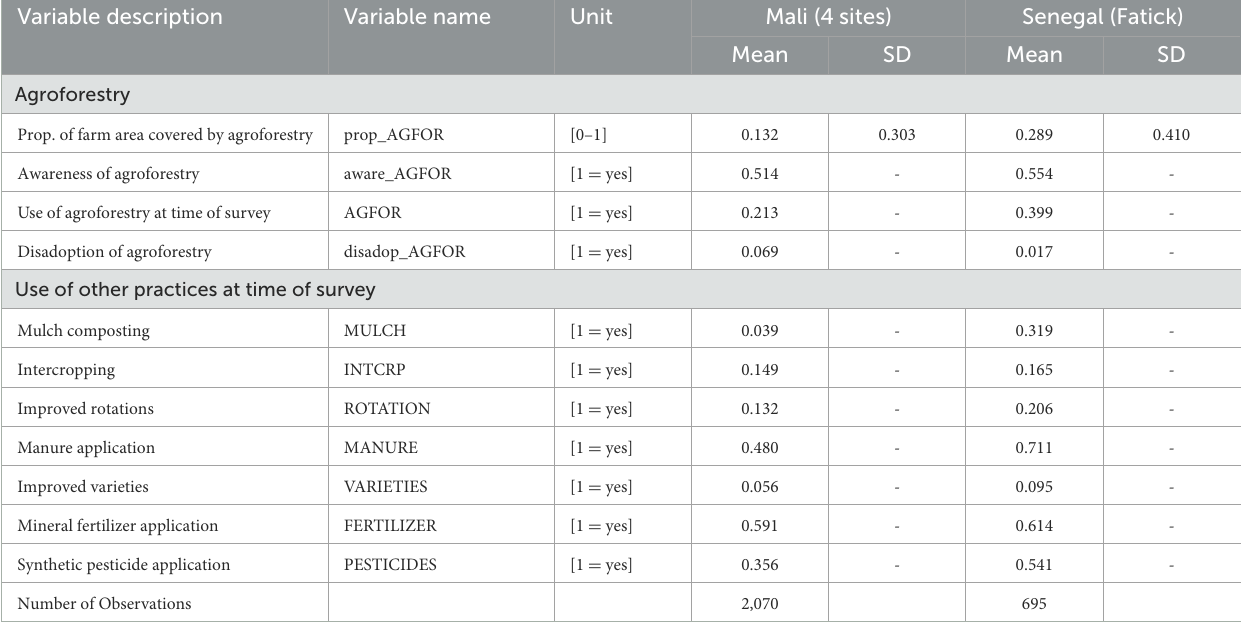
TABLE 1 Descriptive statistics of the response variables included in the econometric